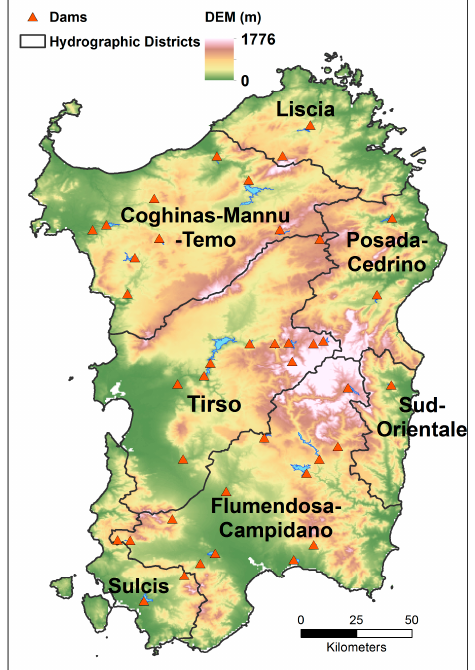
Figure 2. Map of Sardinia, showing the seven hydrological districts and the locations of the reservoirs studied.